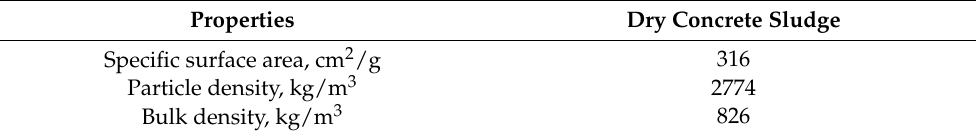
Table 2. Properties of dry concrete